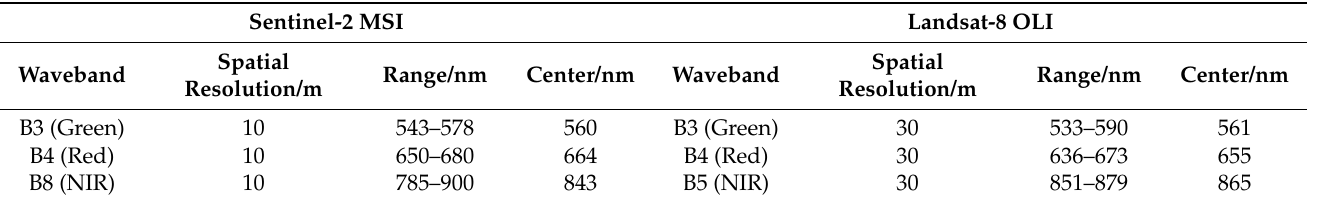
Table 1. Details of the corresponding bands of Sentinel-2 MSI and Landsat-8 OLI used in this